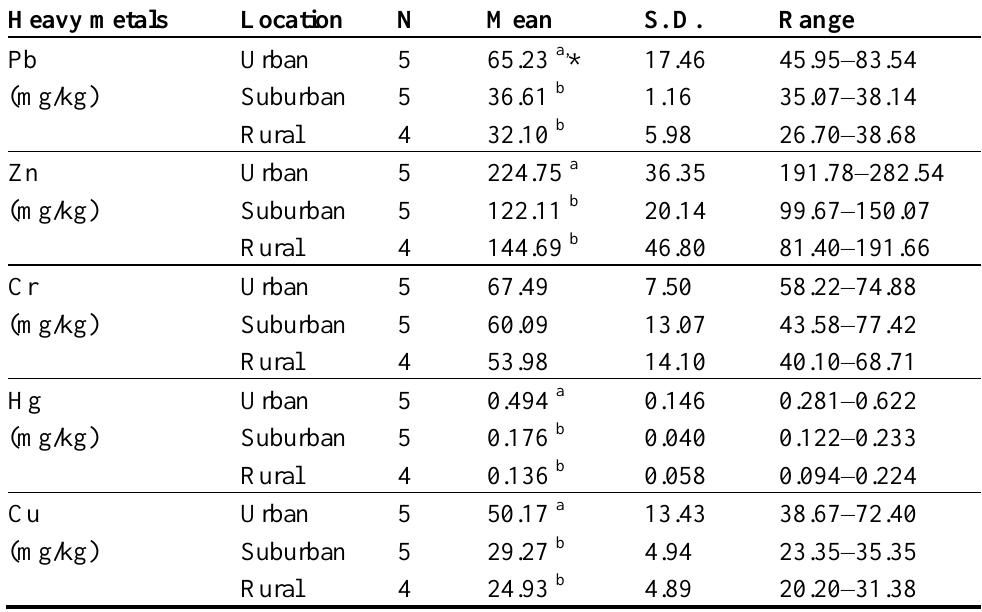
Table1. One-way ANOVA of top-layer soil heavy metal